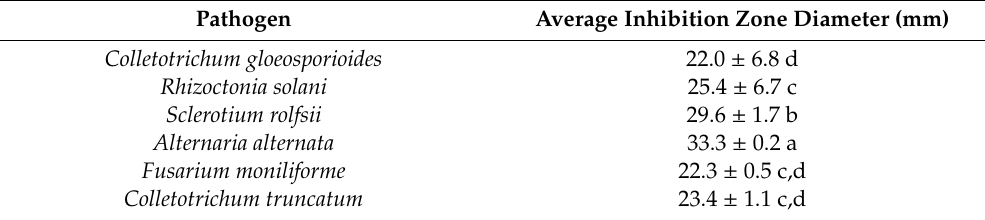
Table 1. Antagonistic activities of strain XS-2 against different plant pathogens.